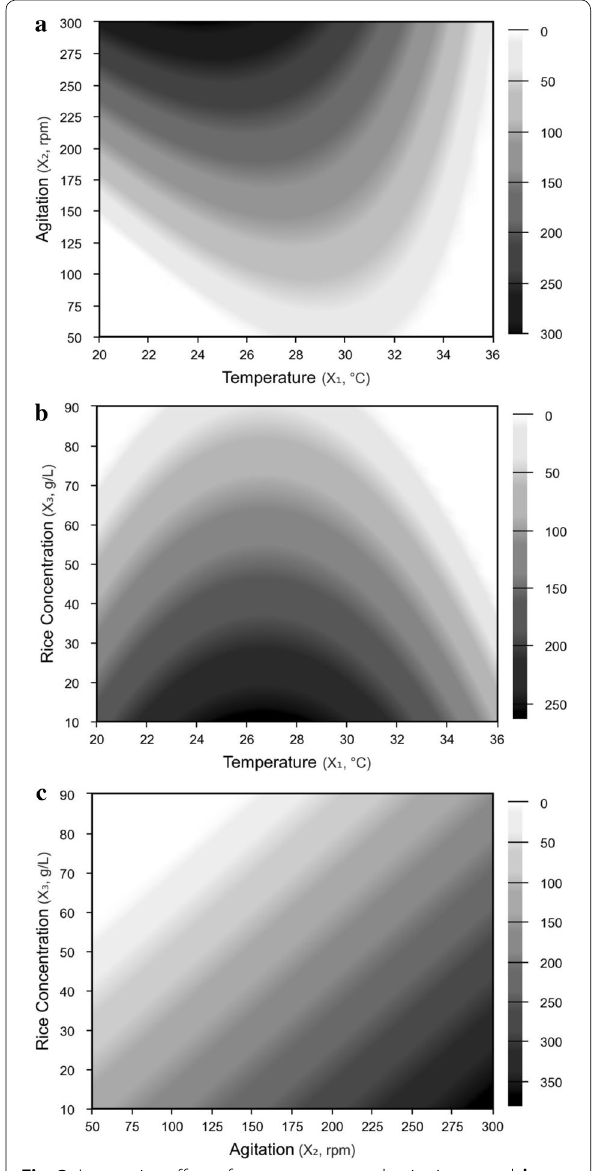
Fig. 3 Interactive effect of a temperature and agitation speed; b temperature and rice concentration; and c agitation speed and rice concentration on bikaverin pigment production (mg/L). Rice concentration, agitation speed, and temperature were kept at 50 g/L, 180 rpm, and 28 °C in Fig. 3a–c,